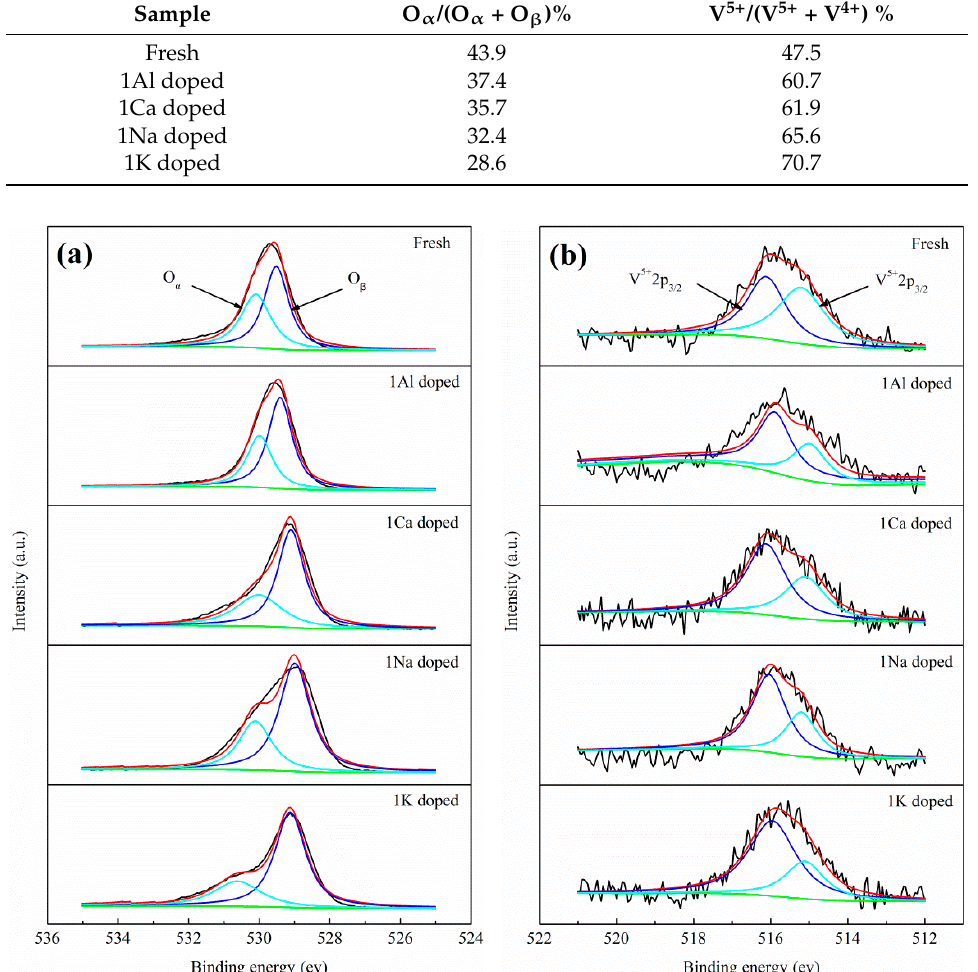
Table 1. XPS data of fresh 1V-5W/Ti and 1 M doped catalysts (M = Al, Ca, Na, and K).